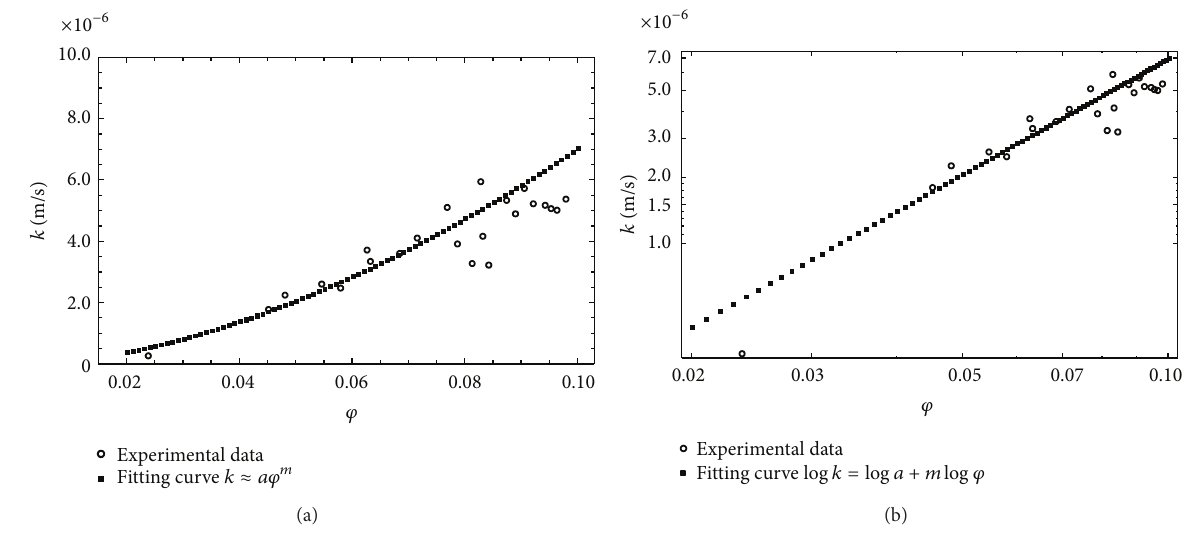
Figure 2: Trend of 𝑘 versus 𝜑 𝑒 (𝑠) according to (4): (a) decimal scale; (b) logarithmical scale.